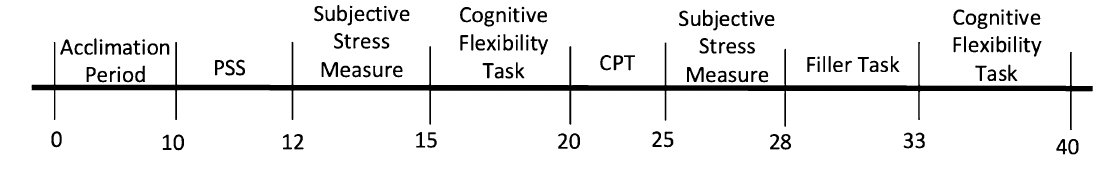
Figure 1. Schematic of study 1 procedure; PSS perceived chronic stress scale, CPT cold pressor